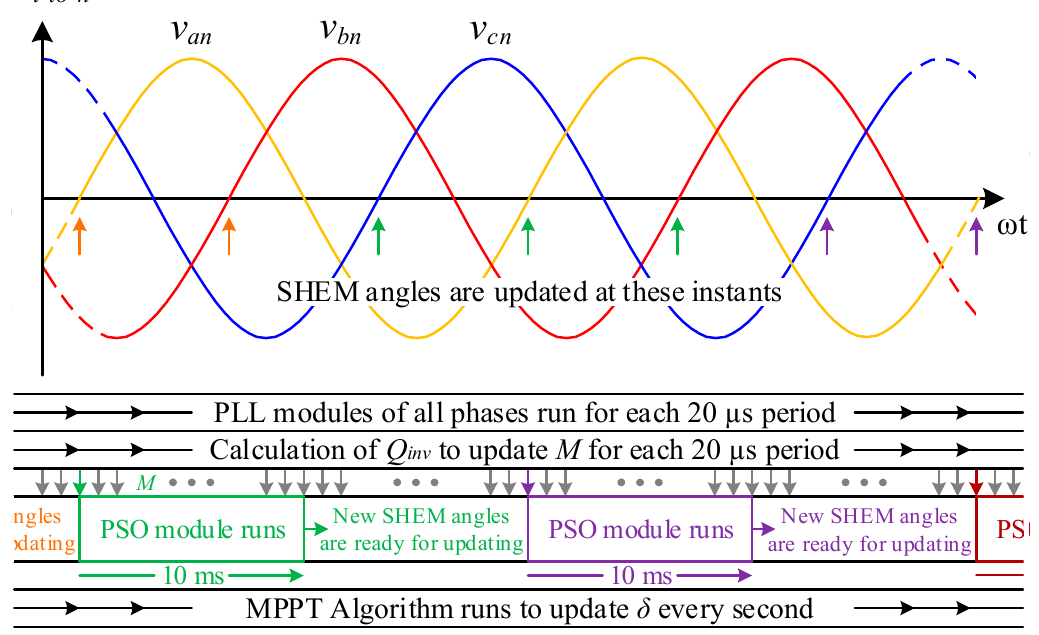
Figure 9. Timing diagram illustrating all control actions and on-line application of SHEM for the sample system in Figure 7.